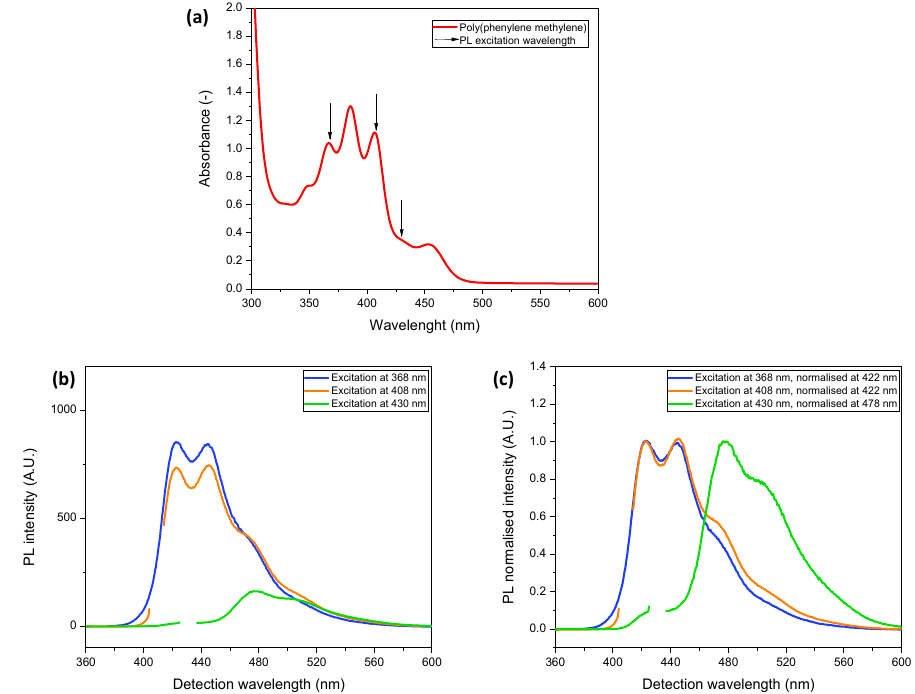
Figure 1. ( a ) UV-vis spectrum of PPM (30 mg/mL in chloroform); ( b ) PL spectra of PPM excited at 368 nm (blue curve), 408 nm (orange curve) and 430 nm (green curve); ( c ) normalized PL spectra related to ( b ).